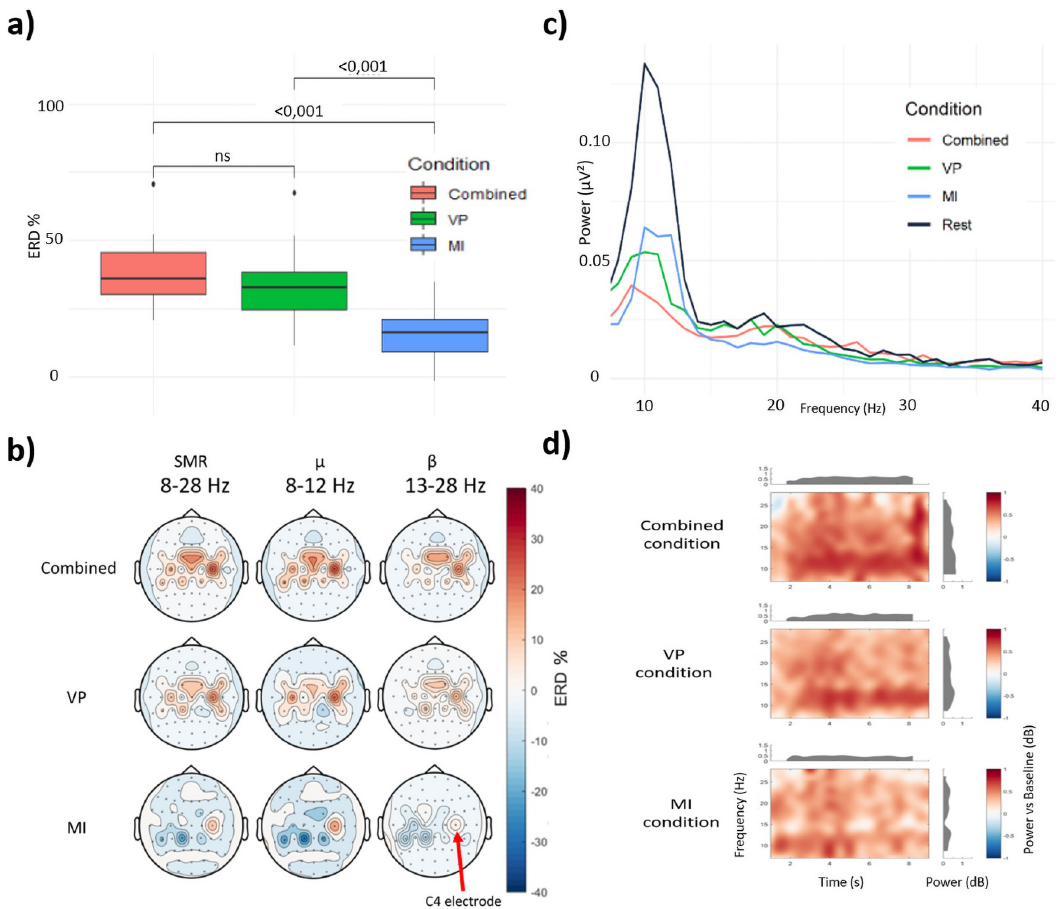
Fig 6. EEG results. a) Boxplot of ERD percentages measured in each condition in the 8–28 Hz bands . The left boxplot represents the ERD percentage on the average of the μ and β frequencies in the combined condition (“Combined”), the second boxplot concerns the VPI condition (VP), the right boxplot concerns the MI condition (M). The crosses represent the means for ERD. NS means “non significant”. b) Topoplots of ERD percentages measured in each condition . The topoplots were averaged across all the participants. They are separated into rows, according to each condition tested (combined condition, VPI condition (VP), motor imagery condition (MI)), and in columns for 8-28Hz ( μ - β bands), 8-13Hz ( μ bands), and 13-28Hz ( β bands). The red arrow locates the position of the C4 electrode. Red represents ERD; blue represents ERS. c) Power spectrum density analysis . Representation of each condition as a function of the signal power in the 8–28 Hz frequency bands on the C4 electrode. Each line represents one condition. Black: Resting state, red: combined condition, green: VPI condition (VP), blue: MI condition. d) Time frequency analysis . Representation of signal power as a function of task completion time (10 seconds) in the 8–28 Hz frequency bands under each condition. From top to bottom: combined condition, VPI condition (VP), MI condition. The red colour represents a greater decrease in signal